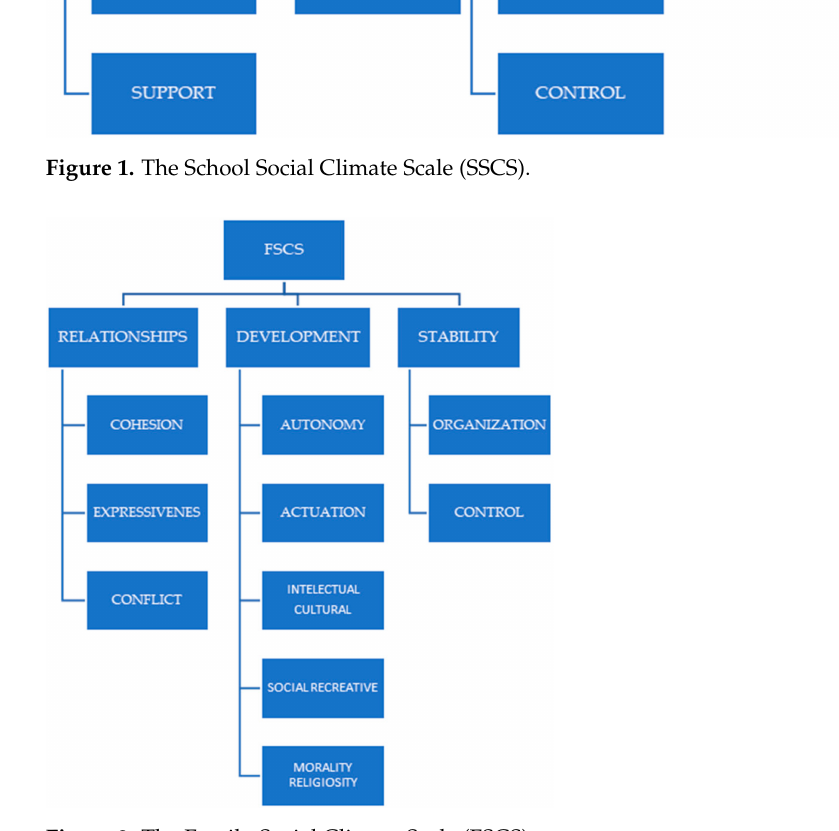
Figure 2. The Family Social Climate Scale